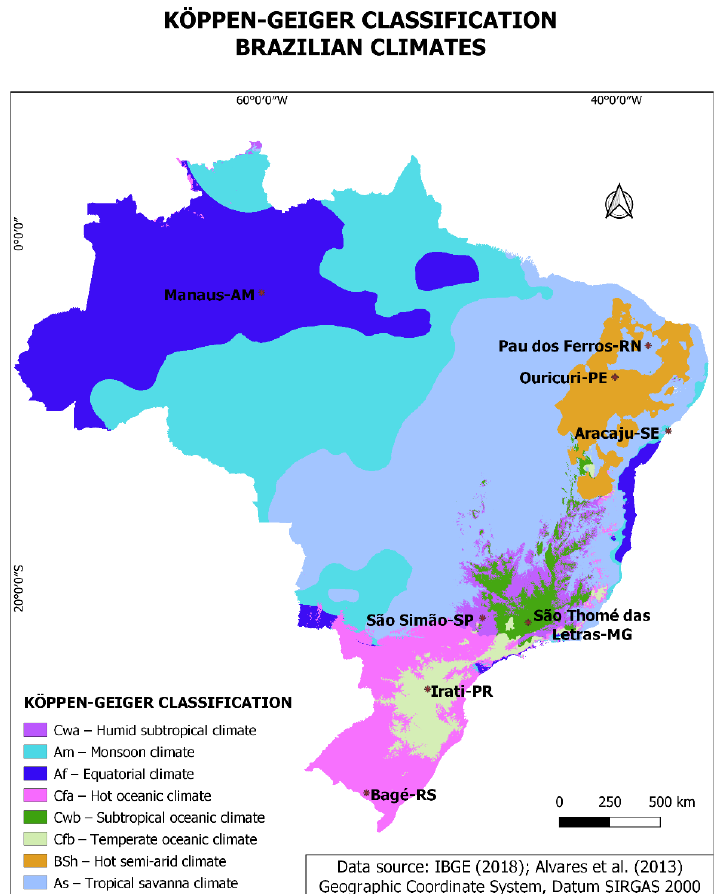
Figure 1. Location map of the analyzed cities in Brazil, within the corresponding climate types; Source: Adapted from IBGE [28] and Alvares et al. [27].